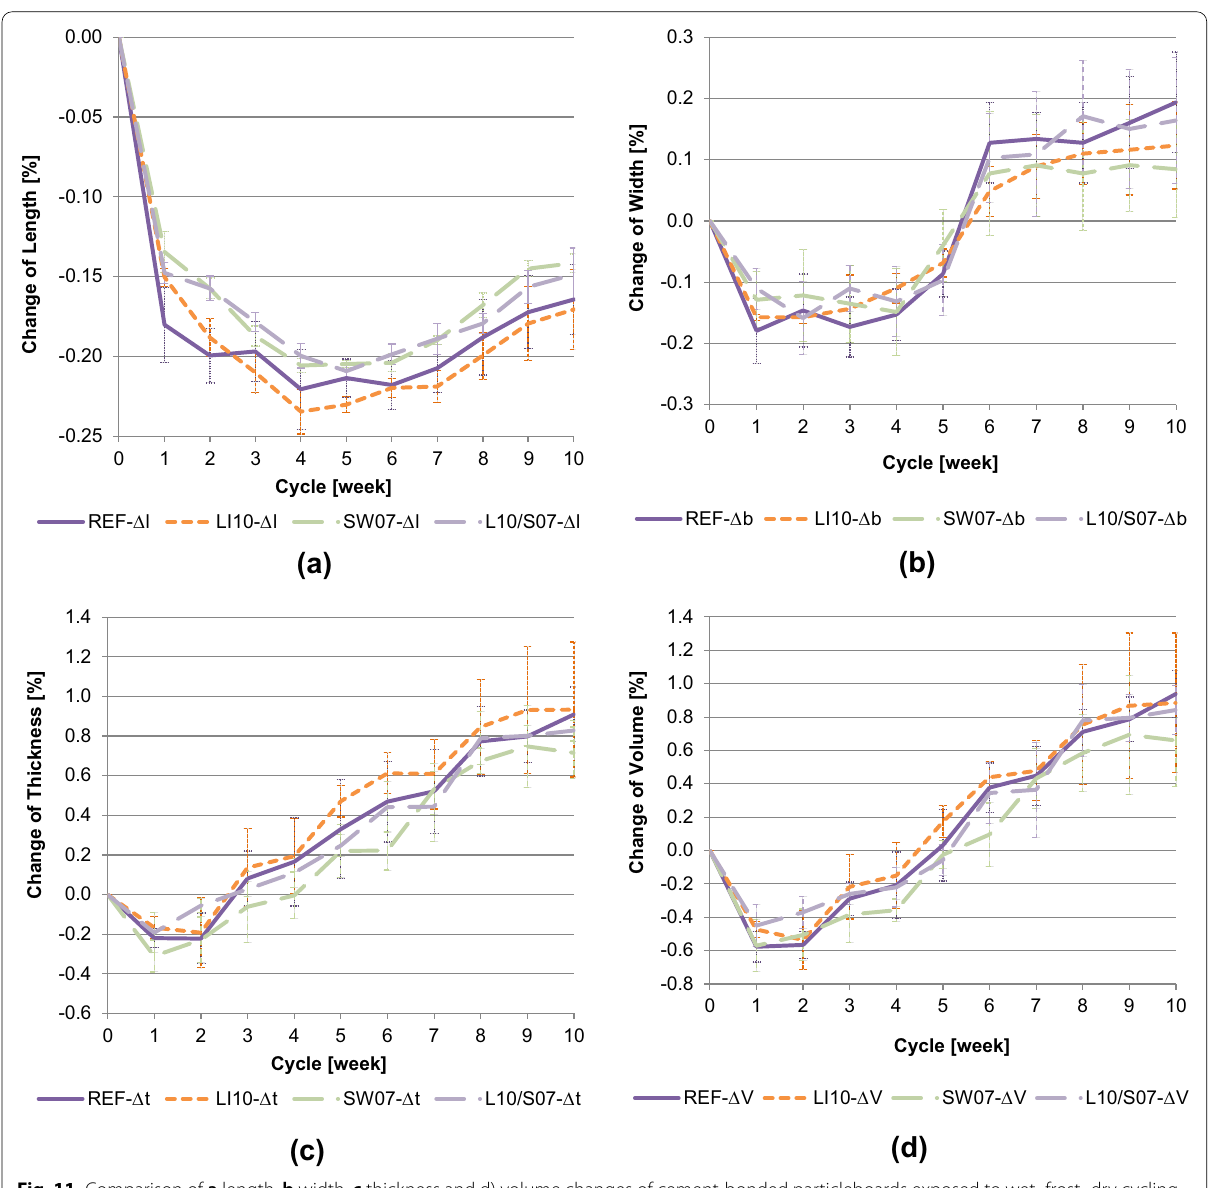
Fig. 11 Comparison of a length, b width, c thickness and d) volume changes of cement-bonded particleboards exposed to wet–frost–dry cycling according to EN